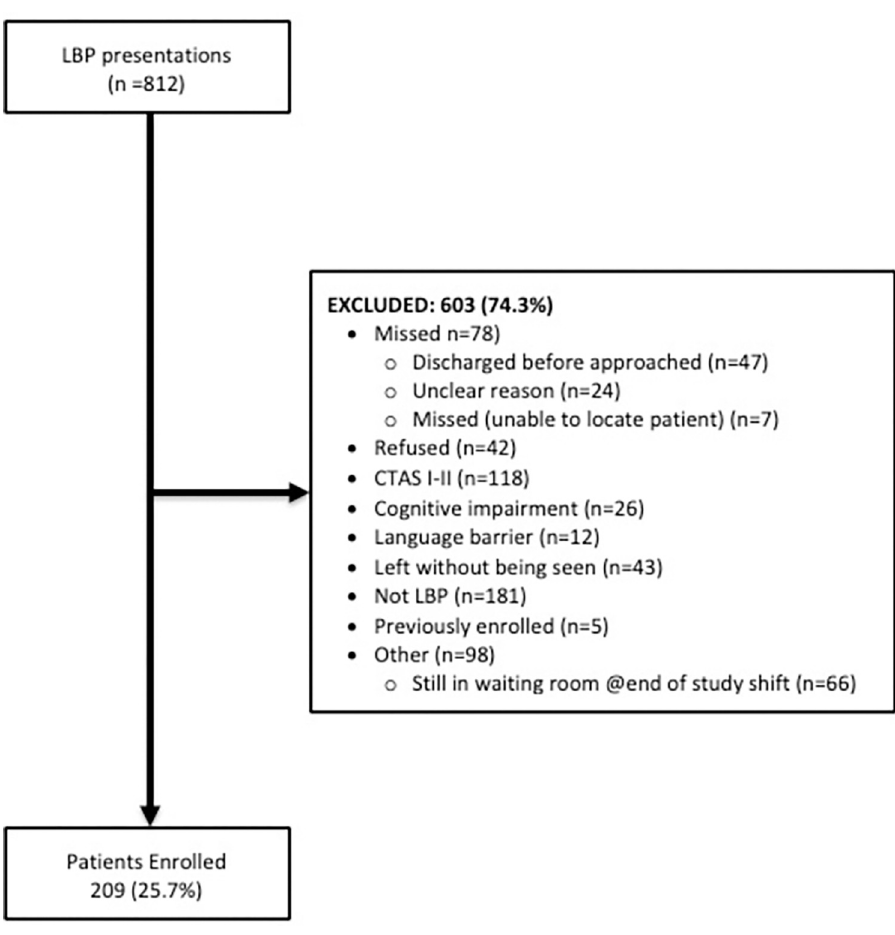
Fig 2. Flowchart of patient